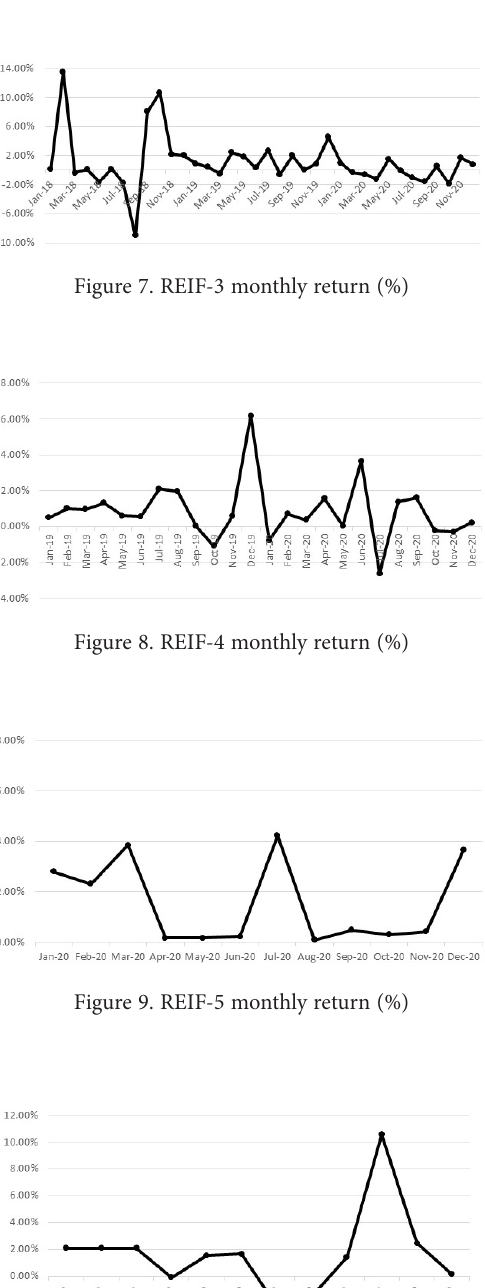
Figure 6. REIF-2 monthly return (%)